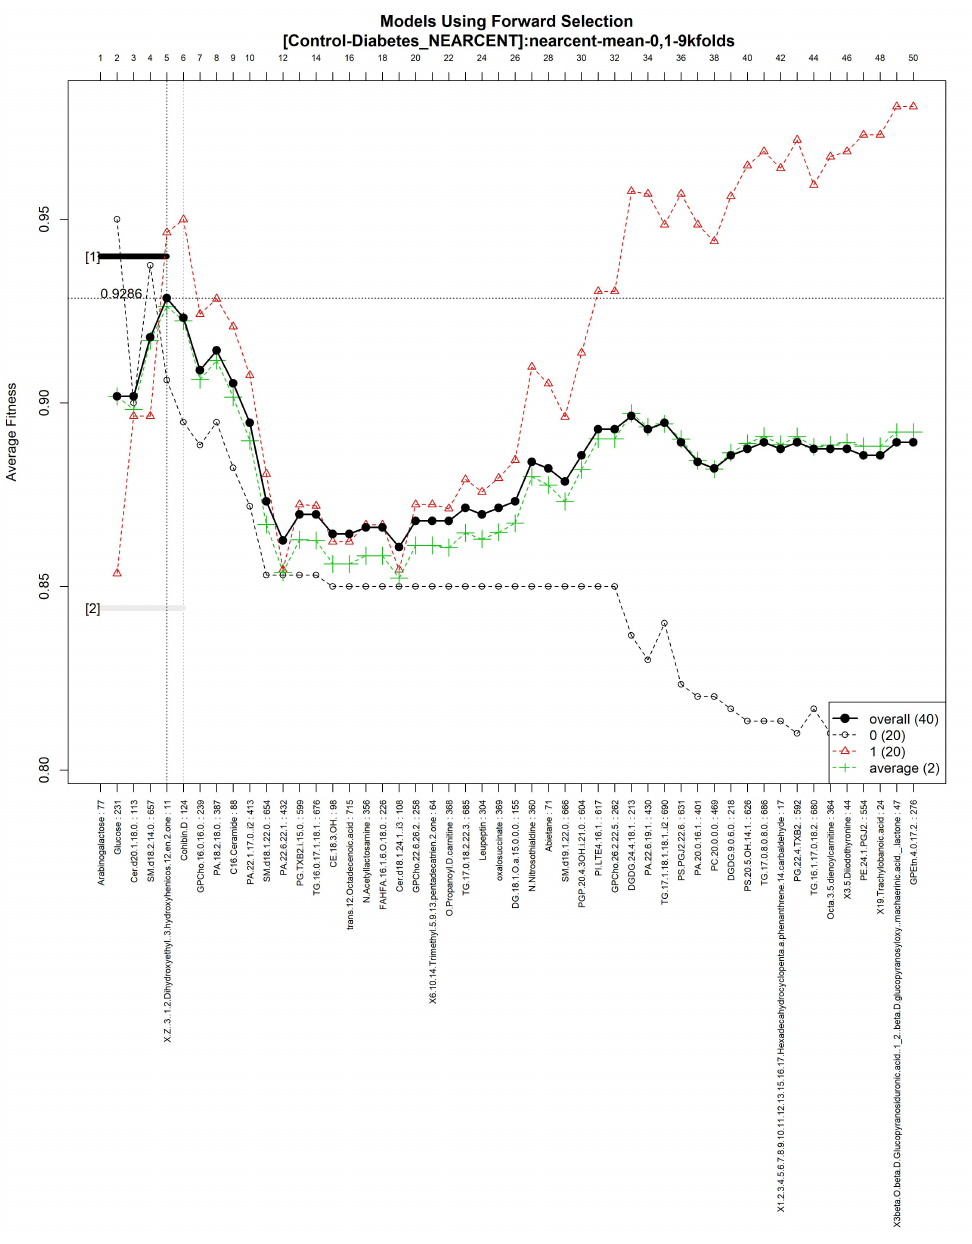
Figure 5. Models using the forward selection methodology, with the Control-T2DM dataset. The solid black line represents the most compact and accurate models. The vertical axis shows the classification accuracy. The horizontal axis represents the ordered features, each of which corresponds to a number. Table 7. Features obtained by GALGO NEARCENT method in the Control-T2DM